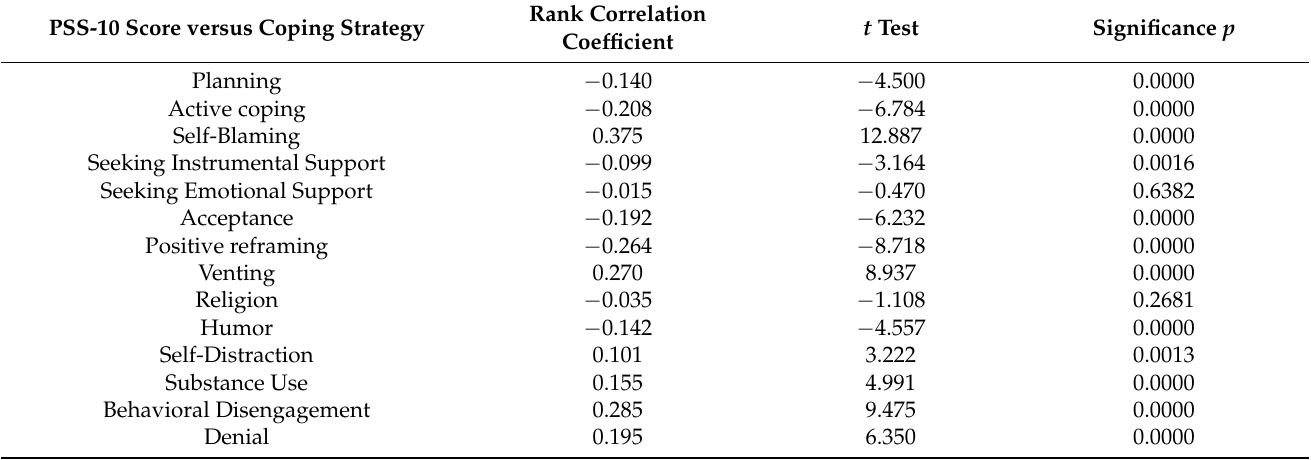
Table 3. Correlation of PSS-10 result vs. most frequently chosen coping strategies.